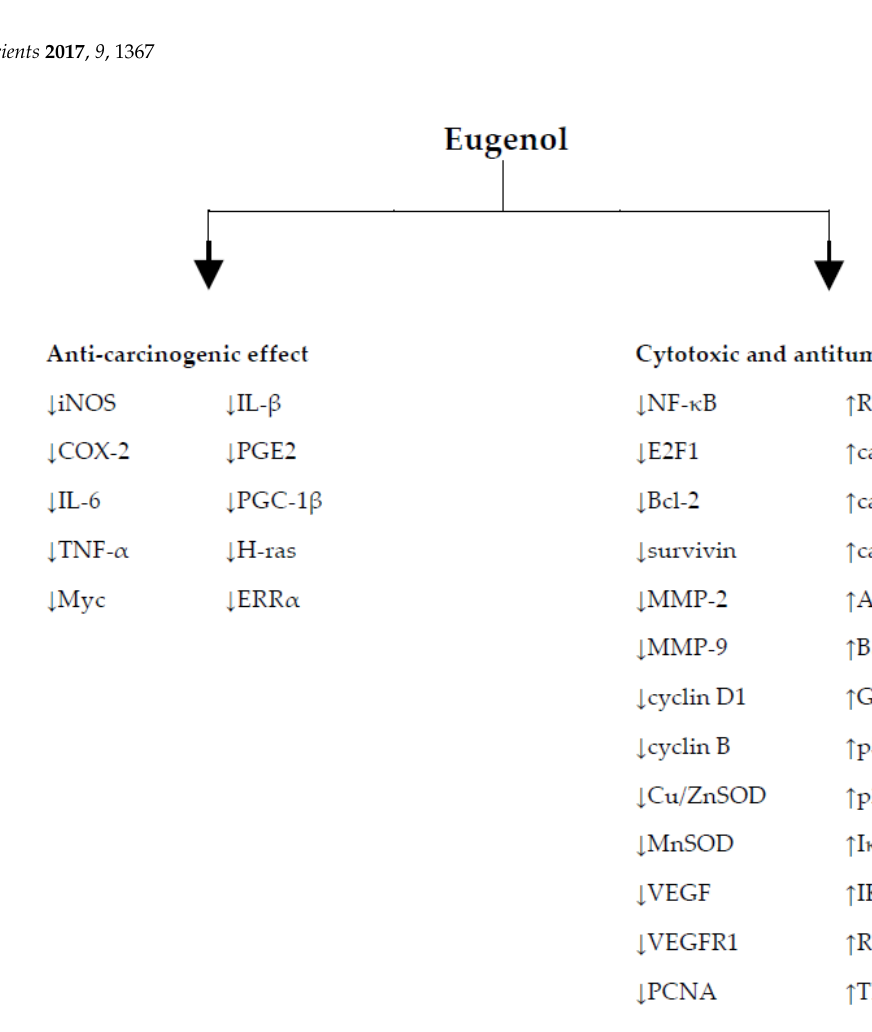
Figure 3. Molecular mechanisms of eugenol. ↑ : upregulation; ↓ : downregulation; Apaf ‐ 1: apoptotic